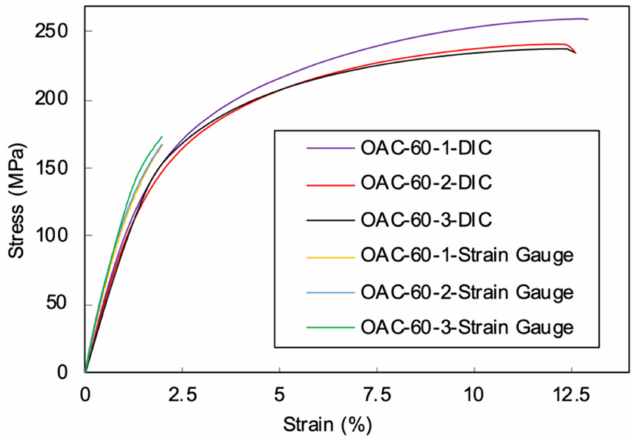
Figure 4. A comparison of the strain data collected from the DIC and strain gauge for the 60 ◦ off-axis compression